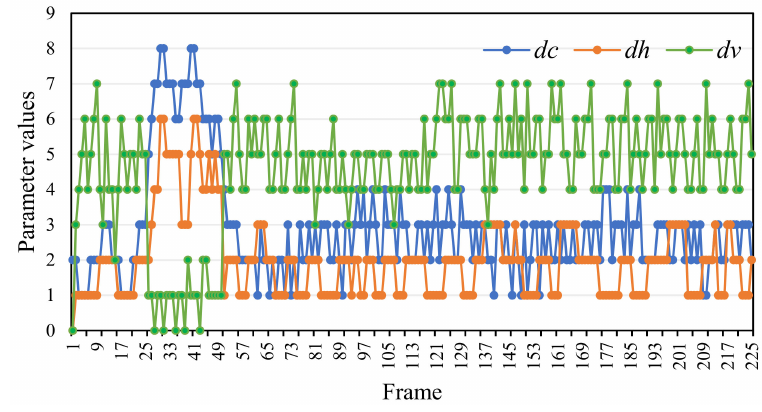
Figure 22. The value of d c , d h and d v for 225 frames in the first video. Table 3. Execution time and false matching rate of di ff erent matching methods for the first video. Method